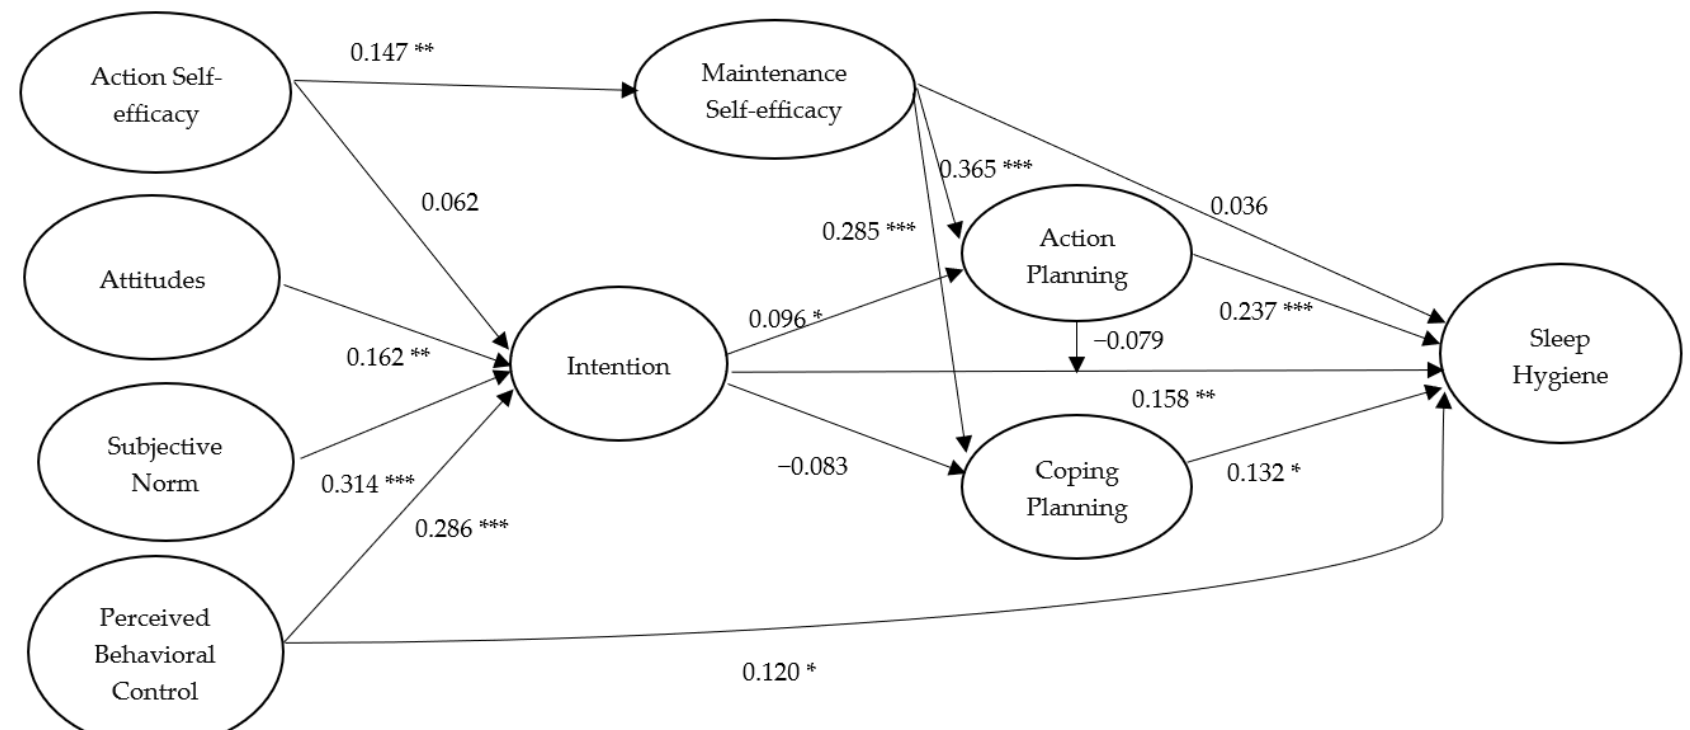
Figure 4. Standardized path coefficients of the Integrated Social-Cognition Model for sleep hygiene. Note. College students’ age and gender were controlled. All hypothesized effects among the psychological and behavioral variables were proposed to be positive in direction. * p < 0.05; ** p < 0.01; *** p < 0.001.